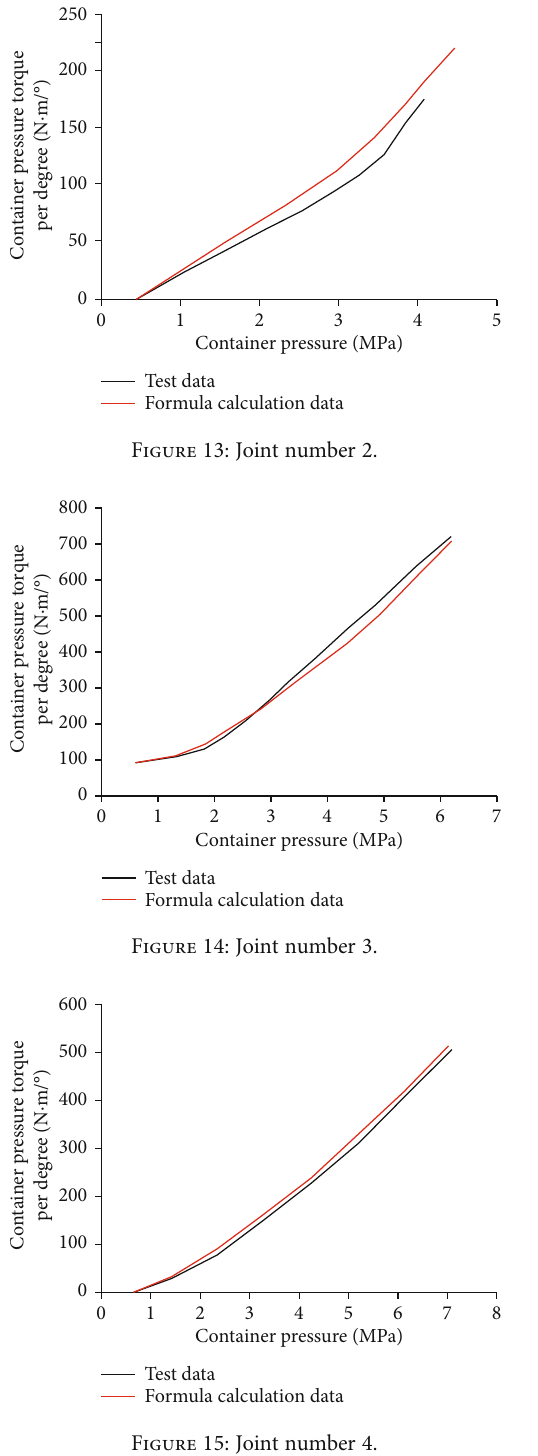
Figure 15: Joint number